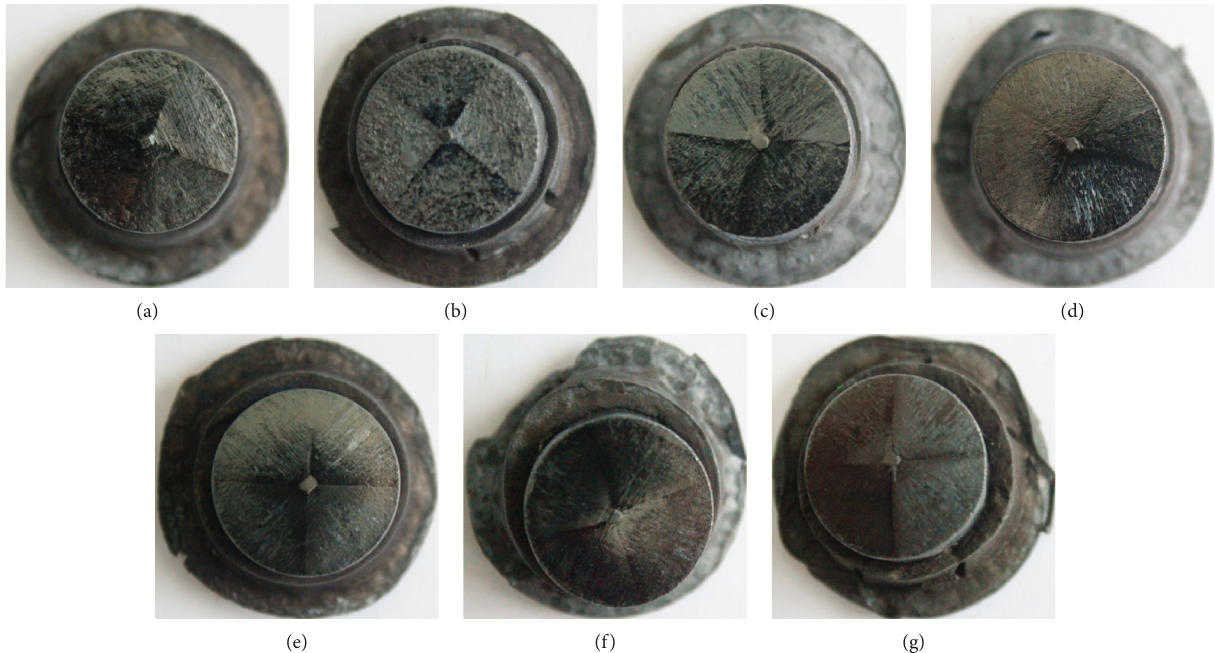
Figure 4: The morphology of the single-domain GdBCO samples prepared with the PSPP sintered at different temperatures. (a) S1 (25 ° C), (b) S2 (950 ° C), (c) S3 (1000 ° C), (d) S4 (1050 ° C), (e) S5 (1100 ° C), (f) S6 (1150 ° C), and (g) S7 (1200 ° C).